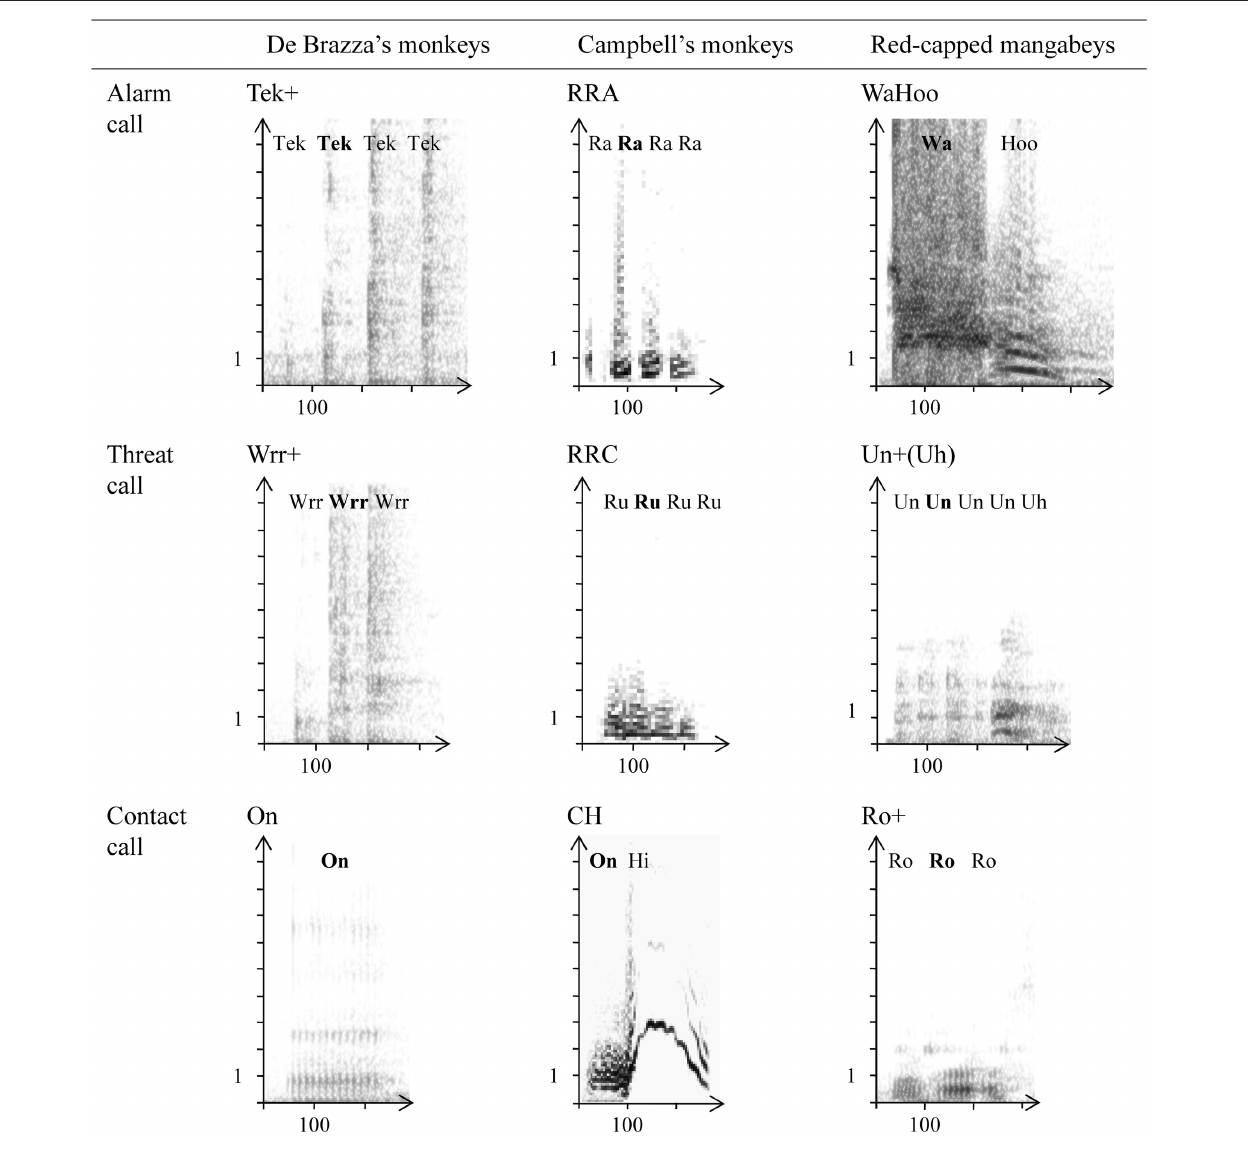
repeated pulses, while red-capped mangabey alarm calls (“WaHoo”) are systematically composed of two units of different types. Guenon threat calls (“Wrr + ” and “RRC”) display an acoustic pattern similar to that of their alarm calls, whereas red-capped mangabey threat calls (“Un + (Uh)”) are composed of one or several short low-pitched tonal units, sometimes combined to an additional “Uh” unit. In the three species, contact calls are composed of one short, low-pitched, tonal unit which is uttered mostly singularly in De Brazza’s monkeys (“On”), combined to a second arched-shape high-pitched unit in Campbell’s monkeys (“CH”), and either singularly or repeated in red-capped mangabeys (“Ro +